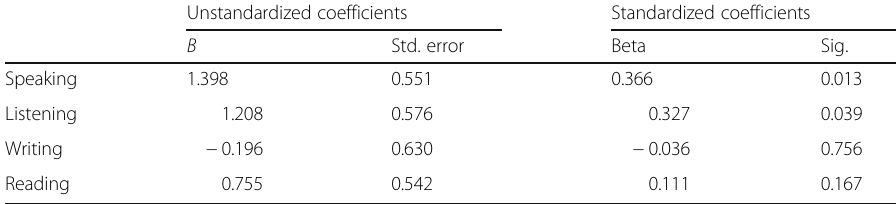
Table 9 The results of multiple regression analysis for the language proficiency subskills and personal